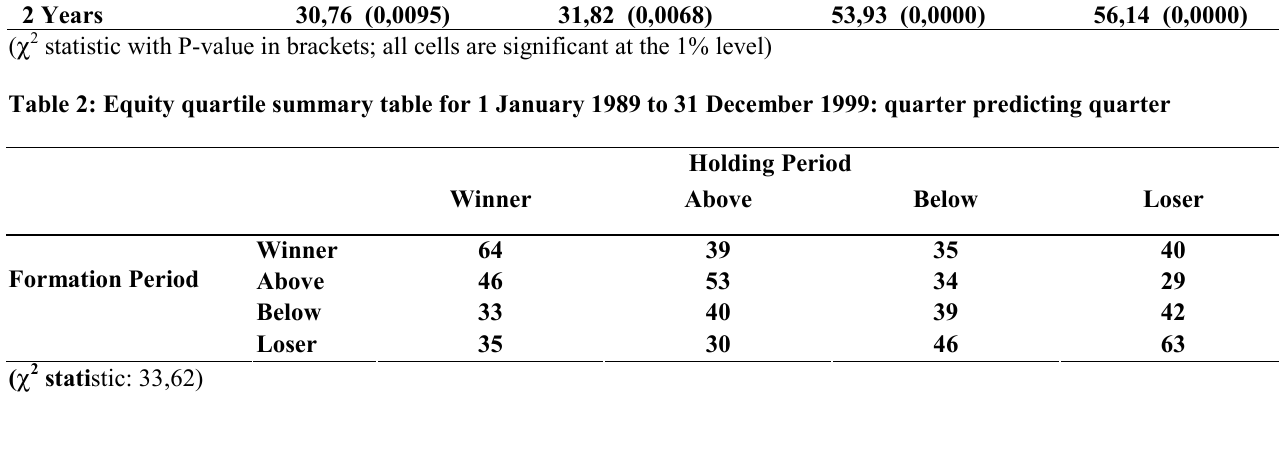
Table 3: Results of the summary tables for general equity funds, the different formation and holding periods using medians